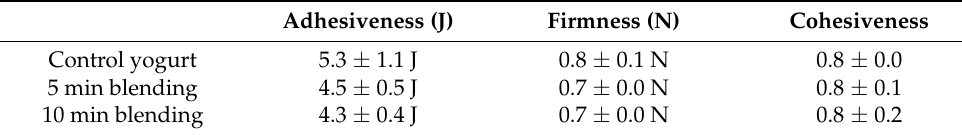
Table 2. Effect of blending on the textural characteristics of fortified yoghurt.